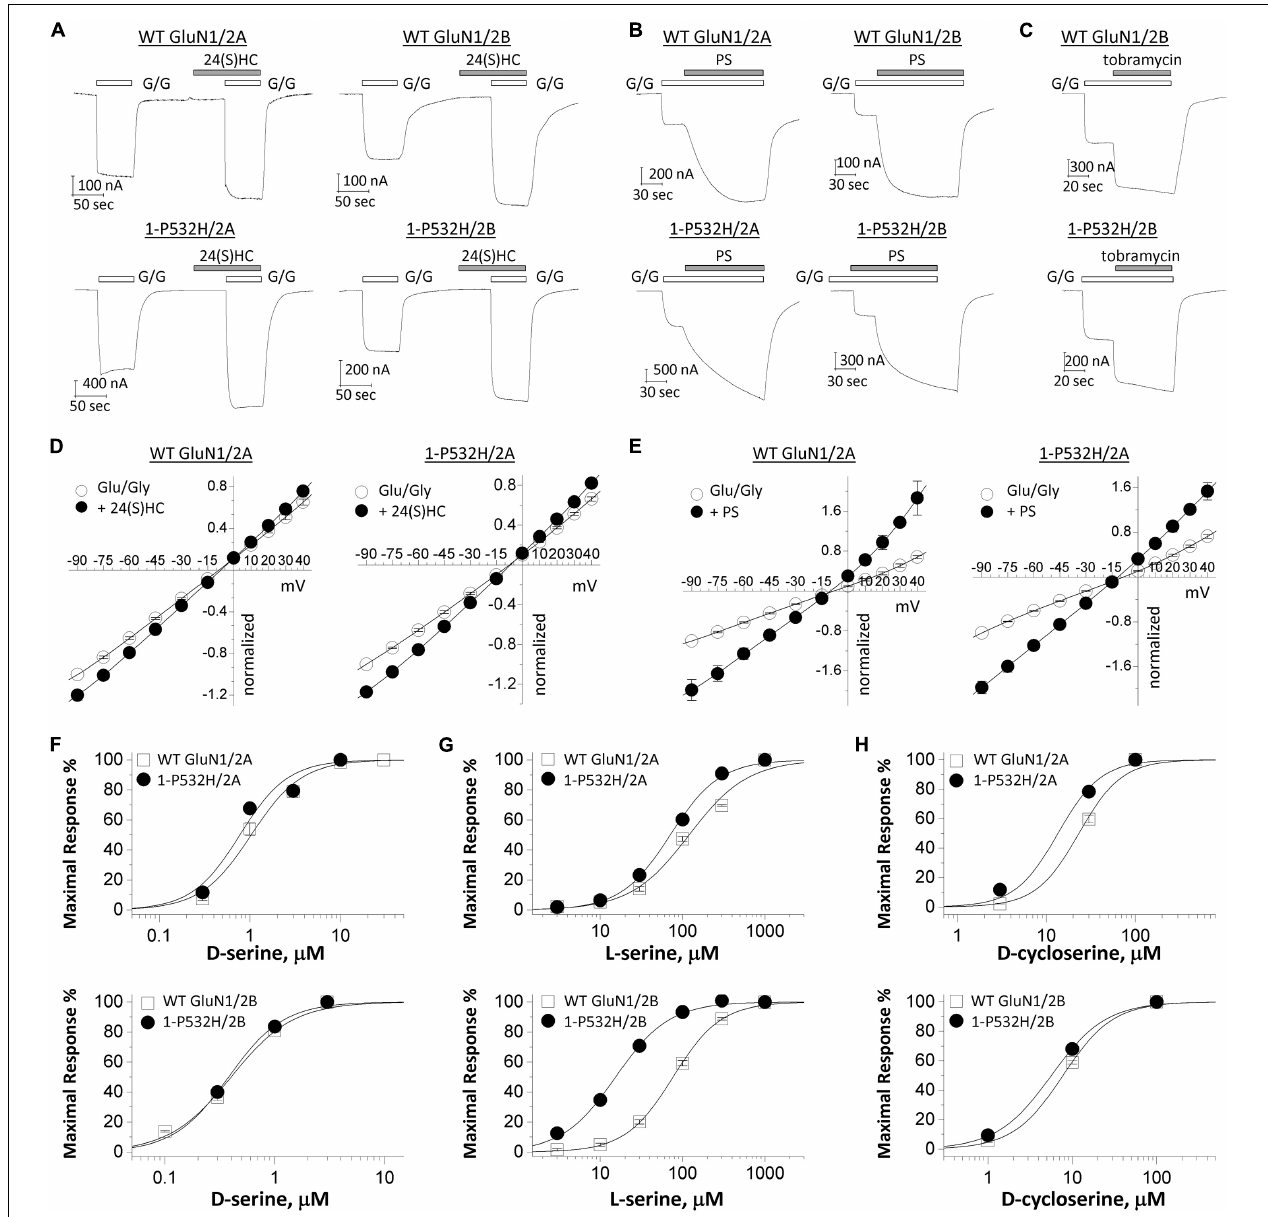
FIGURE 5 | Effects of positive allosteric modulators on loss-of-function GluN1-P532H variant. (A–C) Representative traces of current recordings using two electrode voltage clamp (TEVC) recordings (V HOLD : –40 mV) from Xenopus oocytes showing effects of 10 µ M 24(S)-hydroxycholesterol [24(S)HC], 100 µ M pregnenolone sulfate (PS), and 300 µ M tobramycin on WT GluN1( upper panels ) and GluN1-P532H variant ( lower panels ) when coexpressed with GluN2A or GluN2B. G/G: 1,000 µ M glutamate/100 µ M glycine. (D,E) Current-voltage relationships for WT GluN1 ( left panels ) and GluN1-P532H variant ( right panels ) when coexpressed with GluN2A are shown for the current response to maximally effective concentrations of the agonists (Glu/Gly: 1,000 µ M glutamate and 100 µ M glycine; open circle) and in the agonists supplemented with 10 µ M 24(S)-hydroxycholesterol (filled circle; D ) and 100 µ M pregnenolone sulfate (PS) (filled circle; E ). Data are the mean ± SEM. All data points were normalized to the current response by agonists (Glu/Gly) at –90 mV. The measured voltage at –60 and +30 mV is given in Table 2 . (F–H) Concentration–response curves for coagonists D -serine (F) , L -serine (G) , and D -cycloserine (H) on WT and GluN1-P532H variant when coexpressed with GluN2A ( upper panels ) or GluN2B ( lower panels ) in the presence of 1 mM glutamate were determined from TEVC (V HOLD : –40